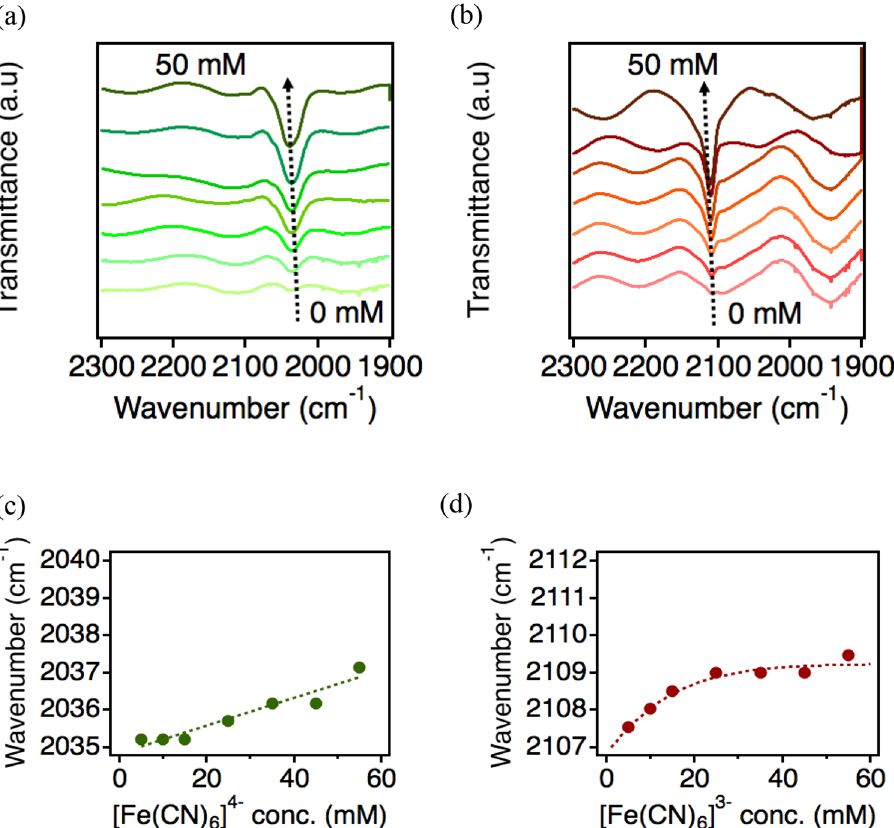
Figure 3. The FT-IR spectra of various concentrations of [Fe(CN) 6 ] 4− ( a ) and [Fe(CN) 6 ] 3− ( b ) in ethaline. C ≡ N stretching modes of the of [Fe(CN) 6 ] 4− and [Fe(CN) 6 ] 3− were fitted using the pseudo-Voight function 29 and the peak wavenumbers were plotted in ( c ) and ( d ),